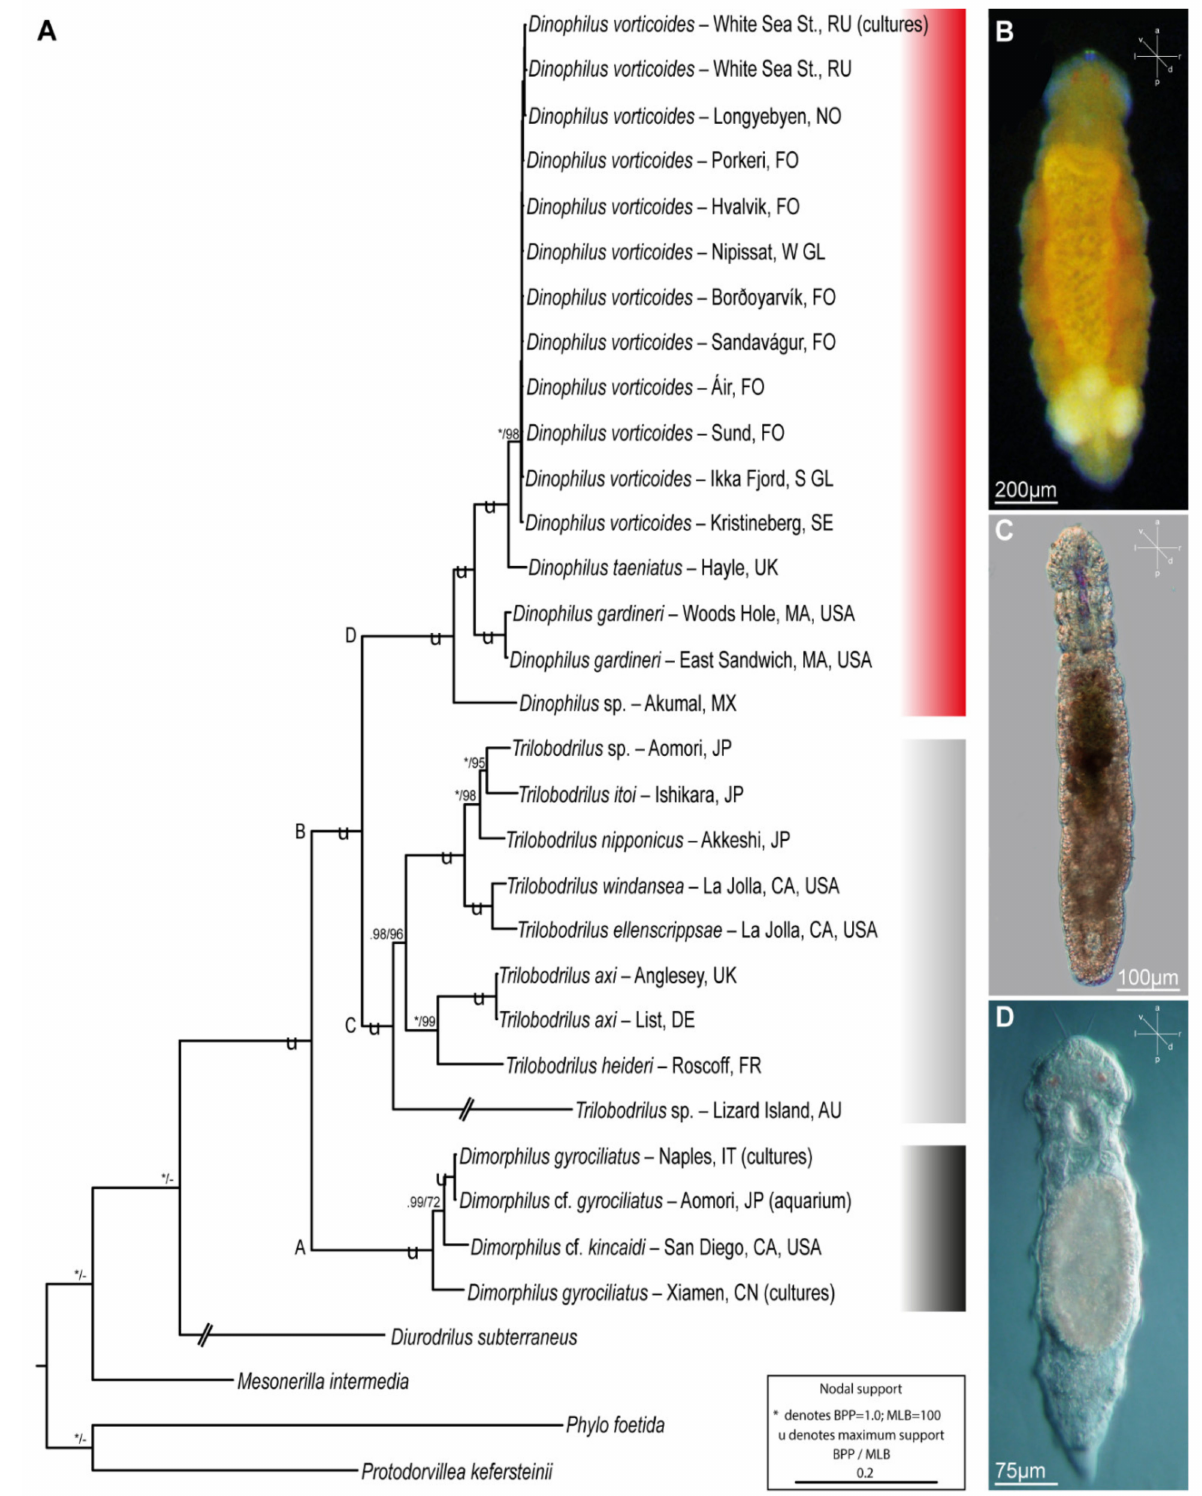
Figure 3. Phylogenetic relationships of Dinophilidae using combined gene analyses (18s rRNA, 28s rRNA, 16s rRNA, COI, CytB); ( A ) tree topology based on Bayesian analyses (BA) of combined gene datasets, nodal support indicated with Bayesian posterior probabilities (BPP) and maximum likelihood bootstrapping (MLB). Only nodal support above BPP = 0.5 or MLB = 50 shown, with those falling below threshold represented by a dash ( − ). “u” indicates maximum support (BPP = 1.0, MLB = 100). Color bars on right margin indicate three recovered clades: red, Dinophilus ; ( B ) grey, Trilobodrilus ; ( C ) black, Dimorphilus ; ( D ). Small crosshairs indicate orientation. Images modified from